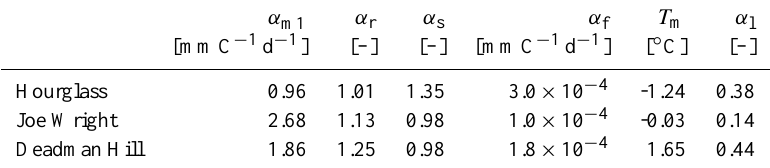
Table 2. Optimal parameter values estimated for each of the three SNOTEL stations for the C1 model at a daily time step.